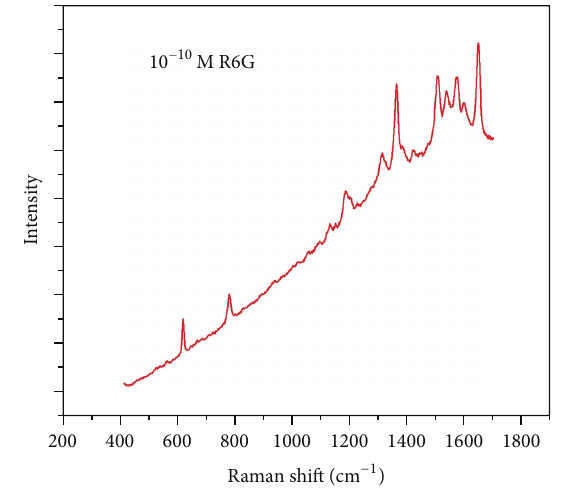
Figure 3: The SERS spectrum of R6G molecules on dendritic Ag